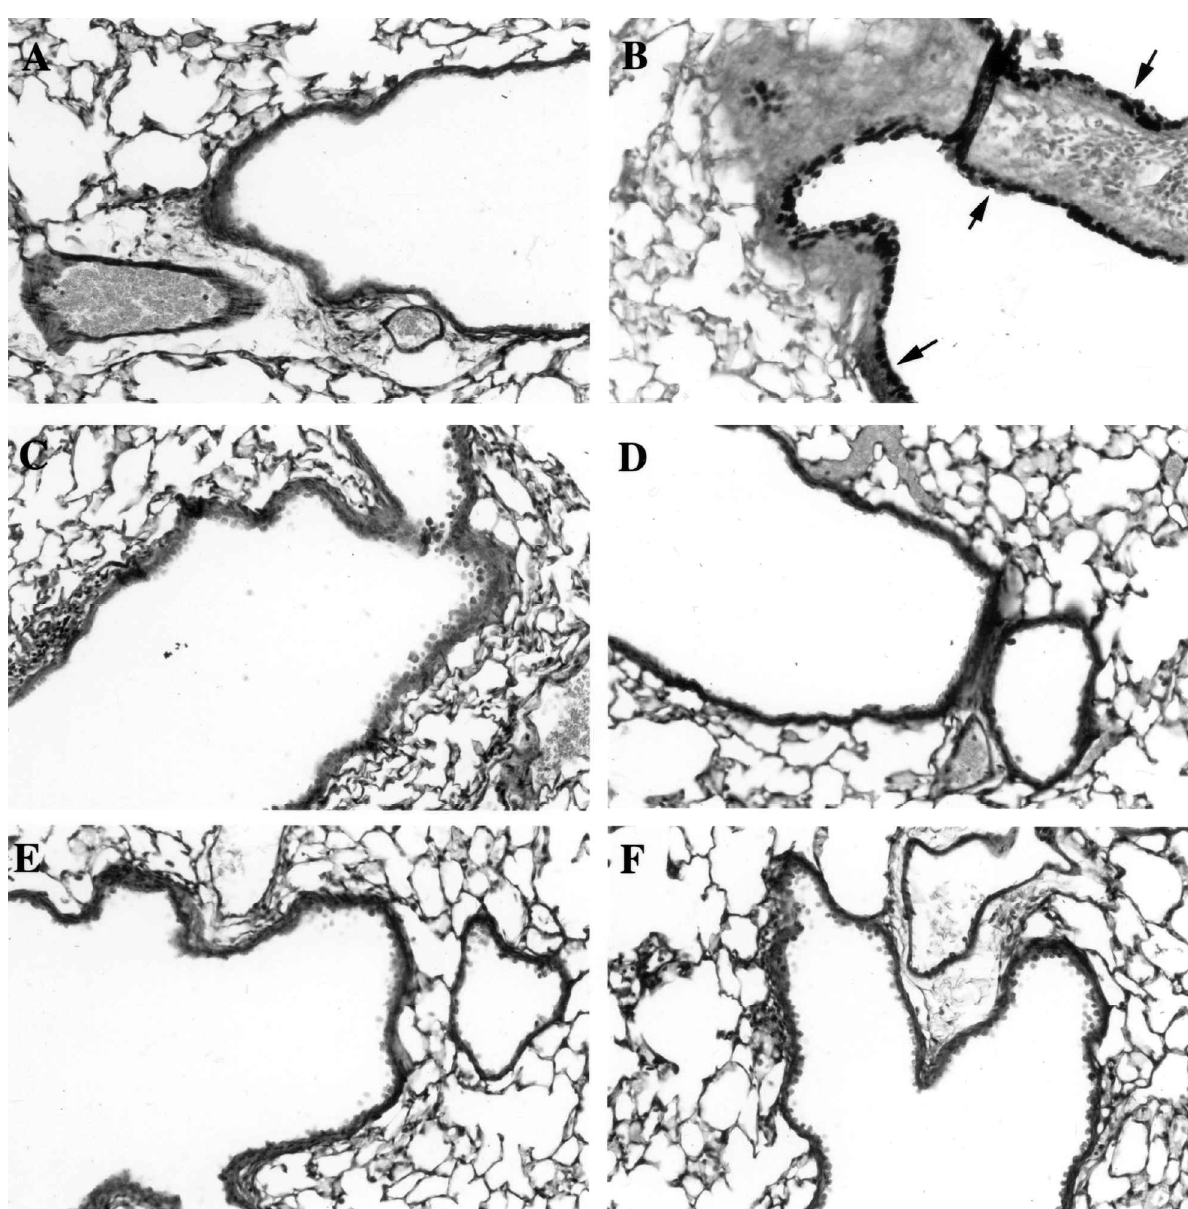
FIG. 6. Periodic acid Schiff (PAS)-stained histologic sections of lungs from allergic mice exposed to NO 2 . At day 14, immunized mice were treated as in Fig. 2. Seventy hours after exposure, lungs were collected for histology. Goblet cells were stained with PAS in lung sections. (A) Lung section of saline-challenged immunized mice exposed to air. (B) Lung section of OVA-challenged immunized mice exposed to air. Note intense goblet cell hyperplasia (arrow). (C) Lung section of saline-challenged immunized mice exposed to NO 2 at 5ppm. (D) Lung section of OVA-challenged immunized mice exposed to NO 2 at 5ppm. (E) Lung section of saline-challenged immunized mice exposed to NO 2 at 20ppm. (F) Lung section of OVA-challenged immunized mice exposed to NO 2 at 20ppm. Note the absence of goblet cell hyperplasia in saline-challenged mice exposed to air or NO 2 in (A), (C) and (E), and in OVA-challenged mice exposed to irrespective of the concentration of NO 2 in (D) and (F) (final magnification, ´